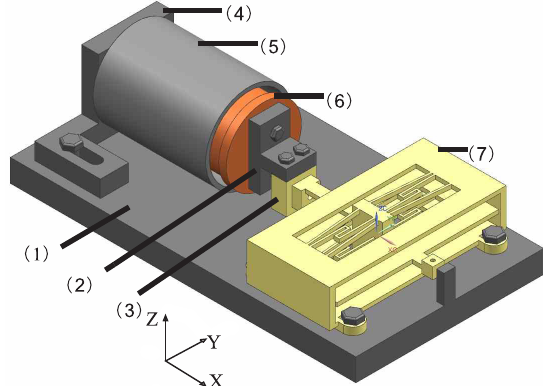
Figure 2. Example of CAD model for the CCFM. (1) Base board, (2) connector 1, (3) connector 2, (4) connector 3, (5) permanent magnetic housing, (6) moving coil, (7) CCFM, (8) end-effector, and (9) fixed end.